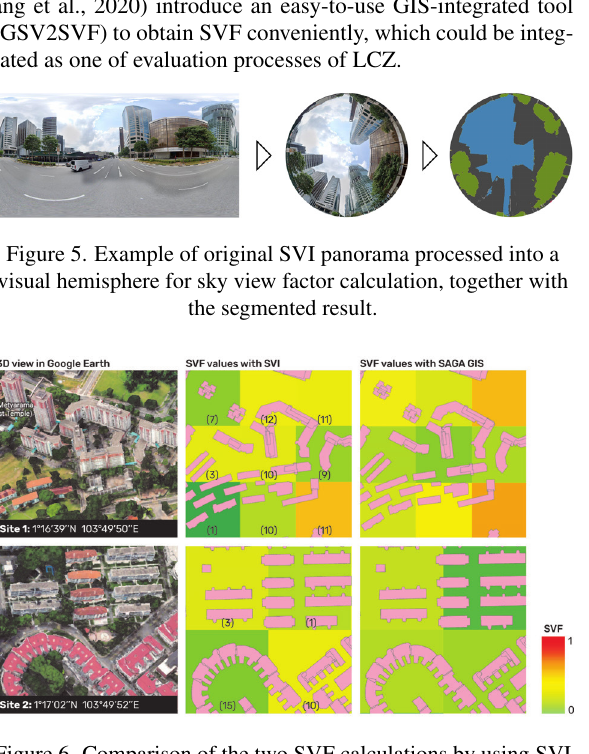
Figure 6. Comparison of the two SVF calculations by using SVI and using SAGA GIS method. The number in the brackets indicates how many SVI points were averaged to obtain the SVF value for each grid. Building footprints were obtained from